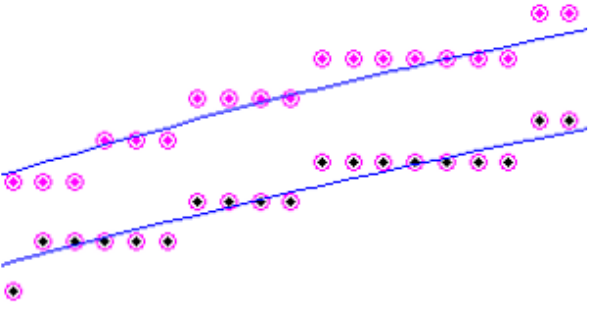
Figure A1. The interpretation of data transmitted by the telemechanic